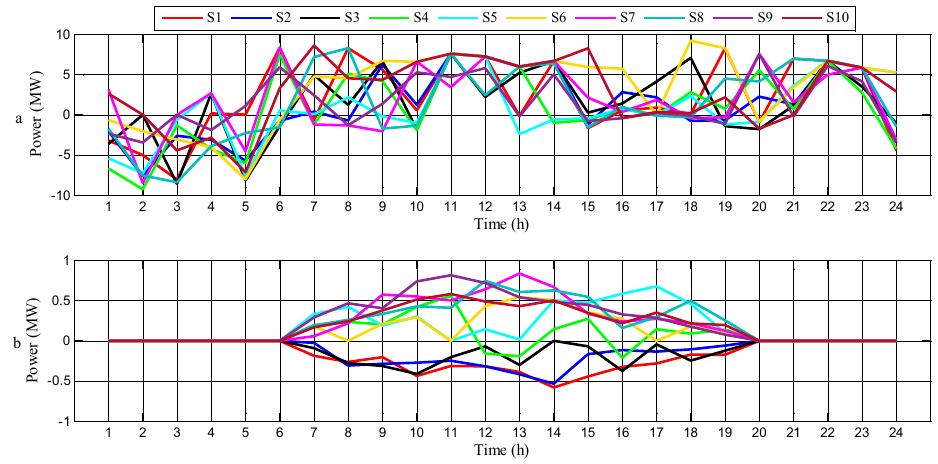
Figure 13. Variation of stochastic parameters. a) WT power variation, b) PV power variation.